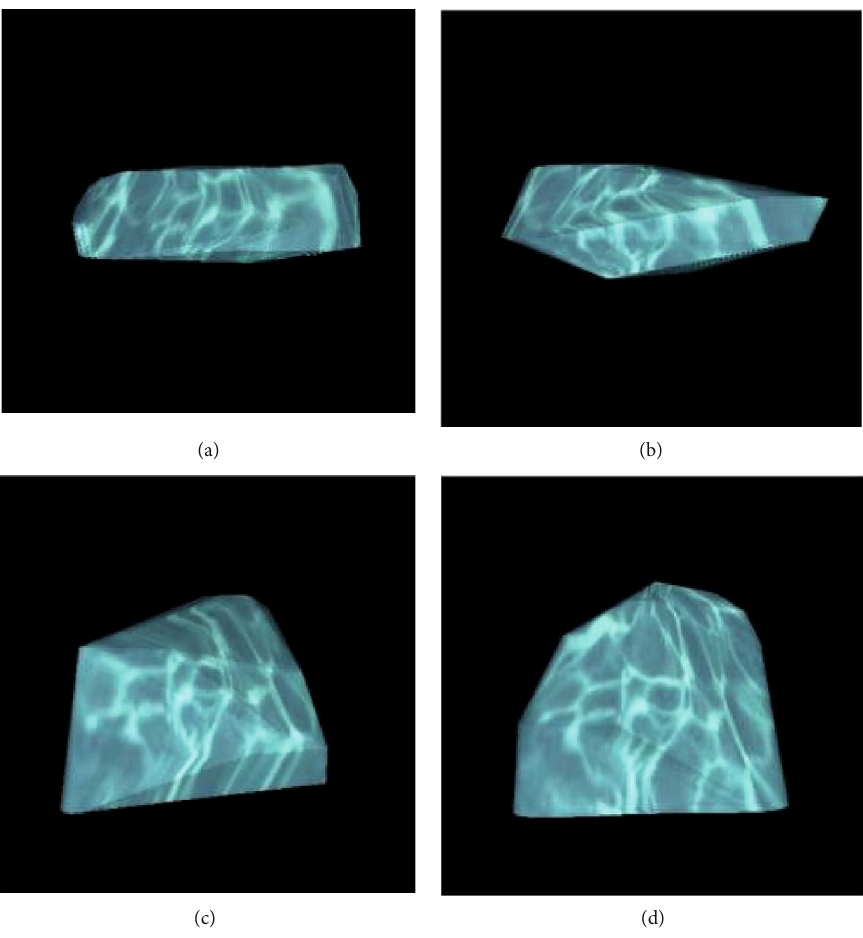
Figure 2: Preoperative and postoperative volume calculations to delineate the lesion from healthy bone. Case report 1: (a, b) preoperative and postoperative volume calculations, respectively. Case report 2: (c, d) preoperative and postoperative volume calculations,